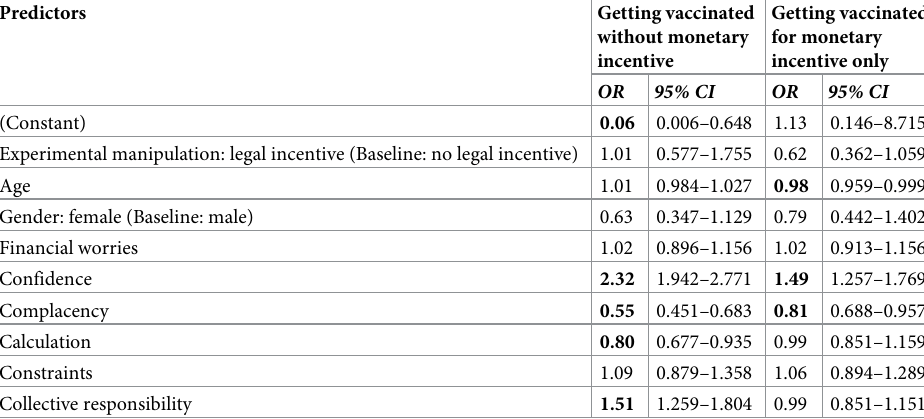
Table 1. Determinants of getting vaccinated with and without monetary incentive. Predictors Getting vaccinated